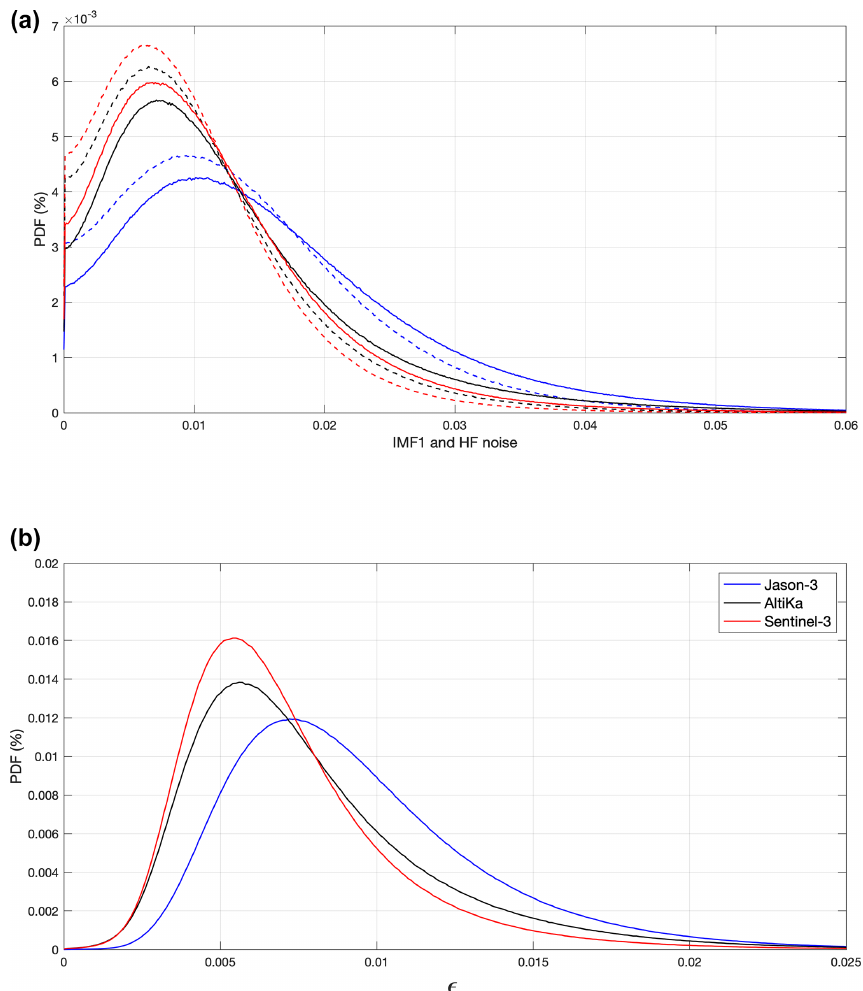
Figure 9. Probability density function (PDF, %) of the absolute values of IMF1 (m, a , solid lines), IMF1 HF noise (m, a , dashed lines), and ε (m, b ), for Jason-3 (blue), AltiKa (black), and Sentinel-3